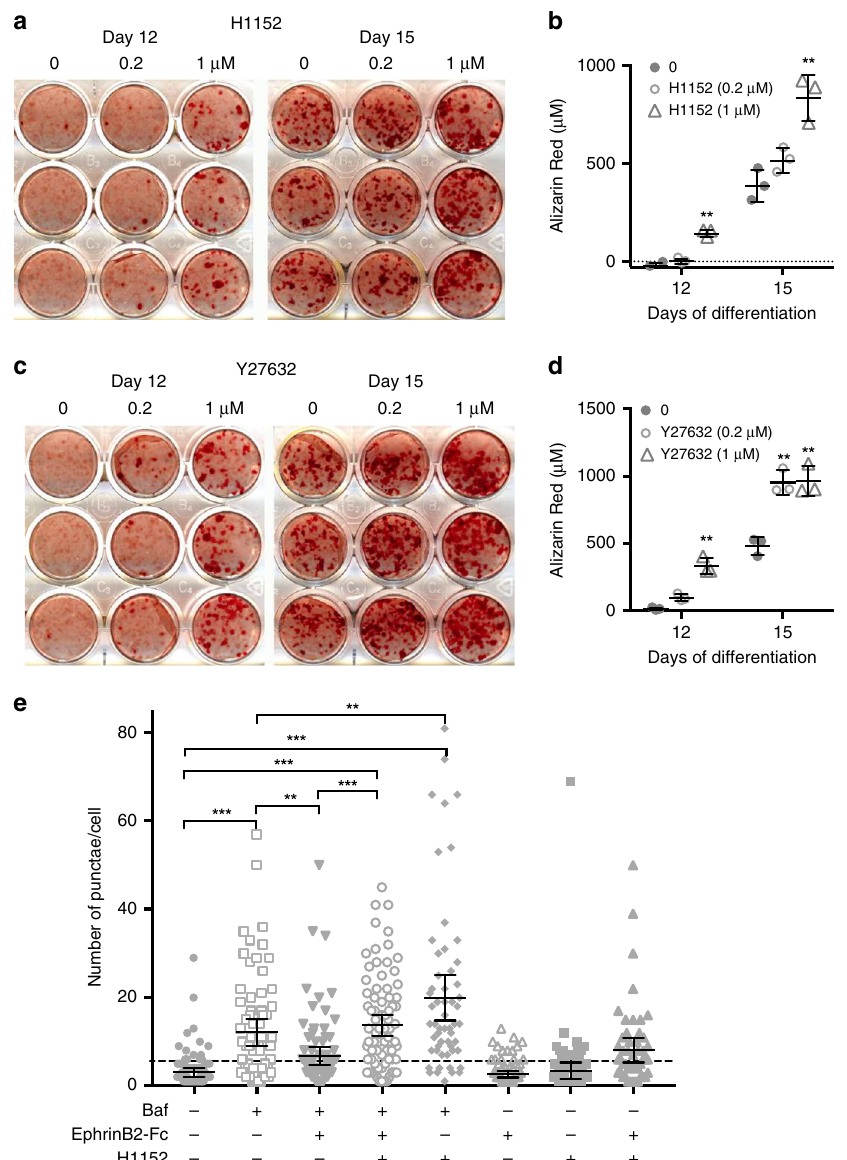
Fig. 7 RhoA-ROCK inhibition increases mineralization and EphrinB2 inhibits autophagy through a RhoA-ROCK-dependent mechanism. a – d Mineralization by Kusa 4b10 cells is enhanced when RhoA-ROCK is inhibited with either H1152 or Y27632. Kusa 4b10 osteocytes were cultured under mineralizing conditions and treated with H1152 ( a , b ) or Y27632 ( c , d ) at the doses indicated for the duration of the culture. Alizarin Red staining and quantitation is shown. Data are mean ± SD of three replicates from a representative of three independent experiments; ** p < 0.01 vs. untreated (0) at same day of differentiation by two-way analysis of variance (ANOVA). e Autophagy is suppressed by EphrinB2 in a RhoA-ROCK-dependent manner. LC3 punctae formation in Ocy454 cells, either untreated or treated with ba fi lomycin A1 (Baf) (50 nM), in the presence and absence of clustered EphrinB2-Fc (1 μ g/mL) and H1152 (50 μ M) for 1 h. Punctae number per cell from two independent experiments, each performed in duplicate, with 95% con fi dence interval (CI); *** p < 0.0001; ** p < 0.001 for comparisons shown, by one-way ANOVA with correction for multiple